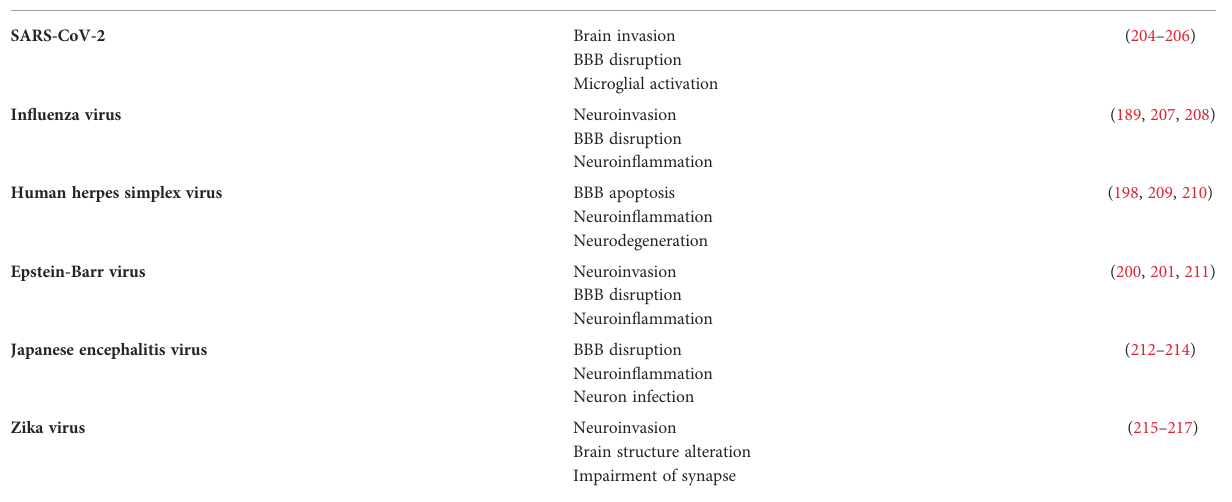
TABLE 2 Association of viral infection and neurological